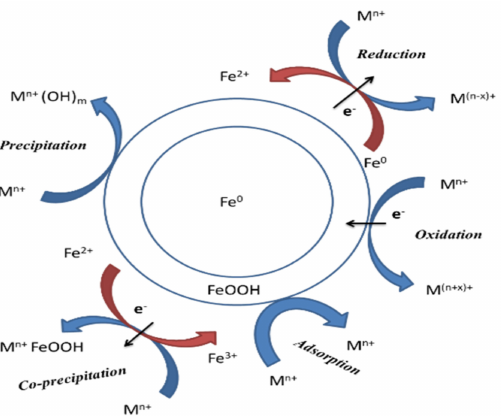
Figure 5. Schematic of a ZVI depicting several interaction mechanisms with heavy